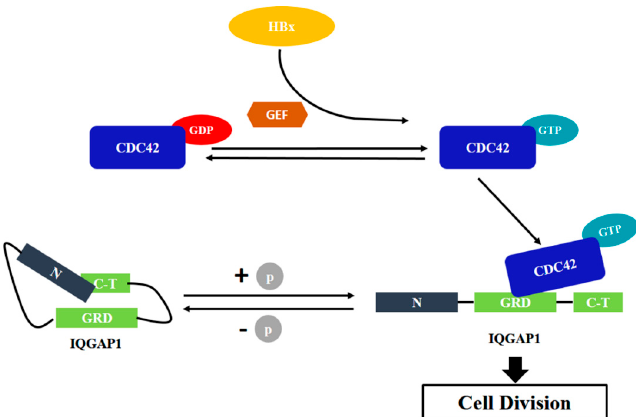
Figure 7. Potential schematic of the HBx-mediated effect of HuH-7 cells. In HBx-expressing HuH-7 cells, both the expression and activity of CDC42 were up-regulated. The accumulated active CDC42 interacted with IQGAP1, resulting in the dysregulation of cell proliferation, which finally caused higher proliferation of HuH-7 cells. GEF, guaninenucleotide exchanging factors; GRD, GTPase-activating protein (GAP)-related domain.